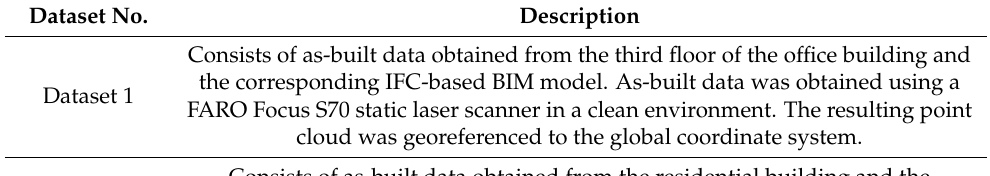
Table 1. A concise description of the